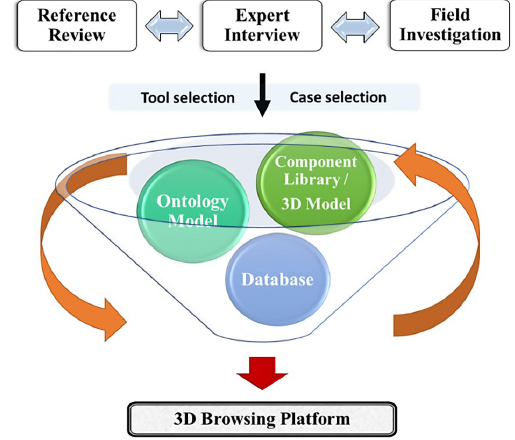
Figure 1. Research process and phased